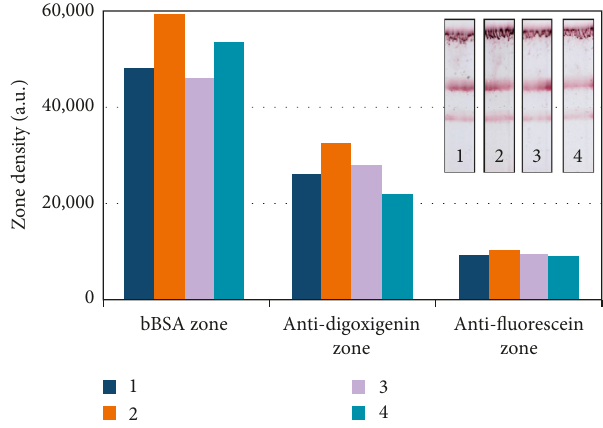
Figure 3: Effect of anti-biotin functionalized gold nanoparticle amount and signal enhancement with nanoparticle aggregates. Representative lateral flow biosensors and signal intensity graphs for Dig- and Fluor-reference target mixtures. Signal is visualized with (1) 30nm gold nanoparticles functionalized with anti-biotin anti- bodies (5 μ L); (2) 30nm Au NPs functionalized with anti-biotin antibodies (10 μ L); (3) 30 nm gold nanoparticles functionalized with anti-biotin antibodies (5 μ L) and 10 nm anti-BSA conju- gated Au NPs (5 μ L); and (4) 30 nm gold nanoparticles func- tionalized with anti-biotin antibodies (5 μ L) and 5 nm anti-BSA conjugated NPs (5 μ